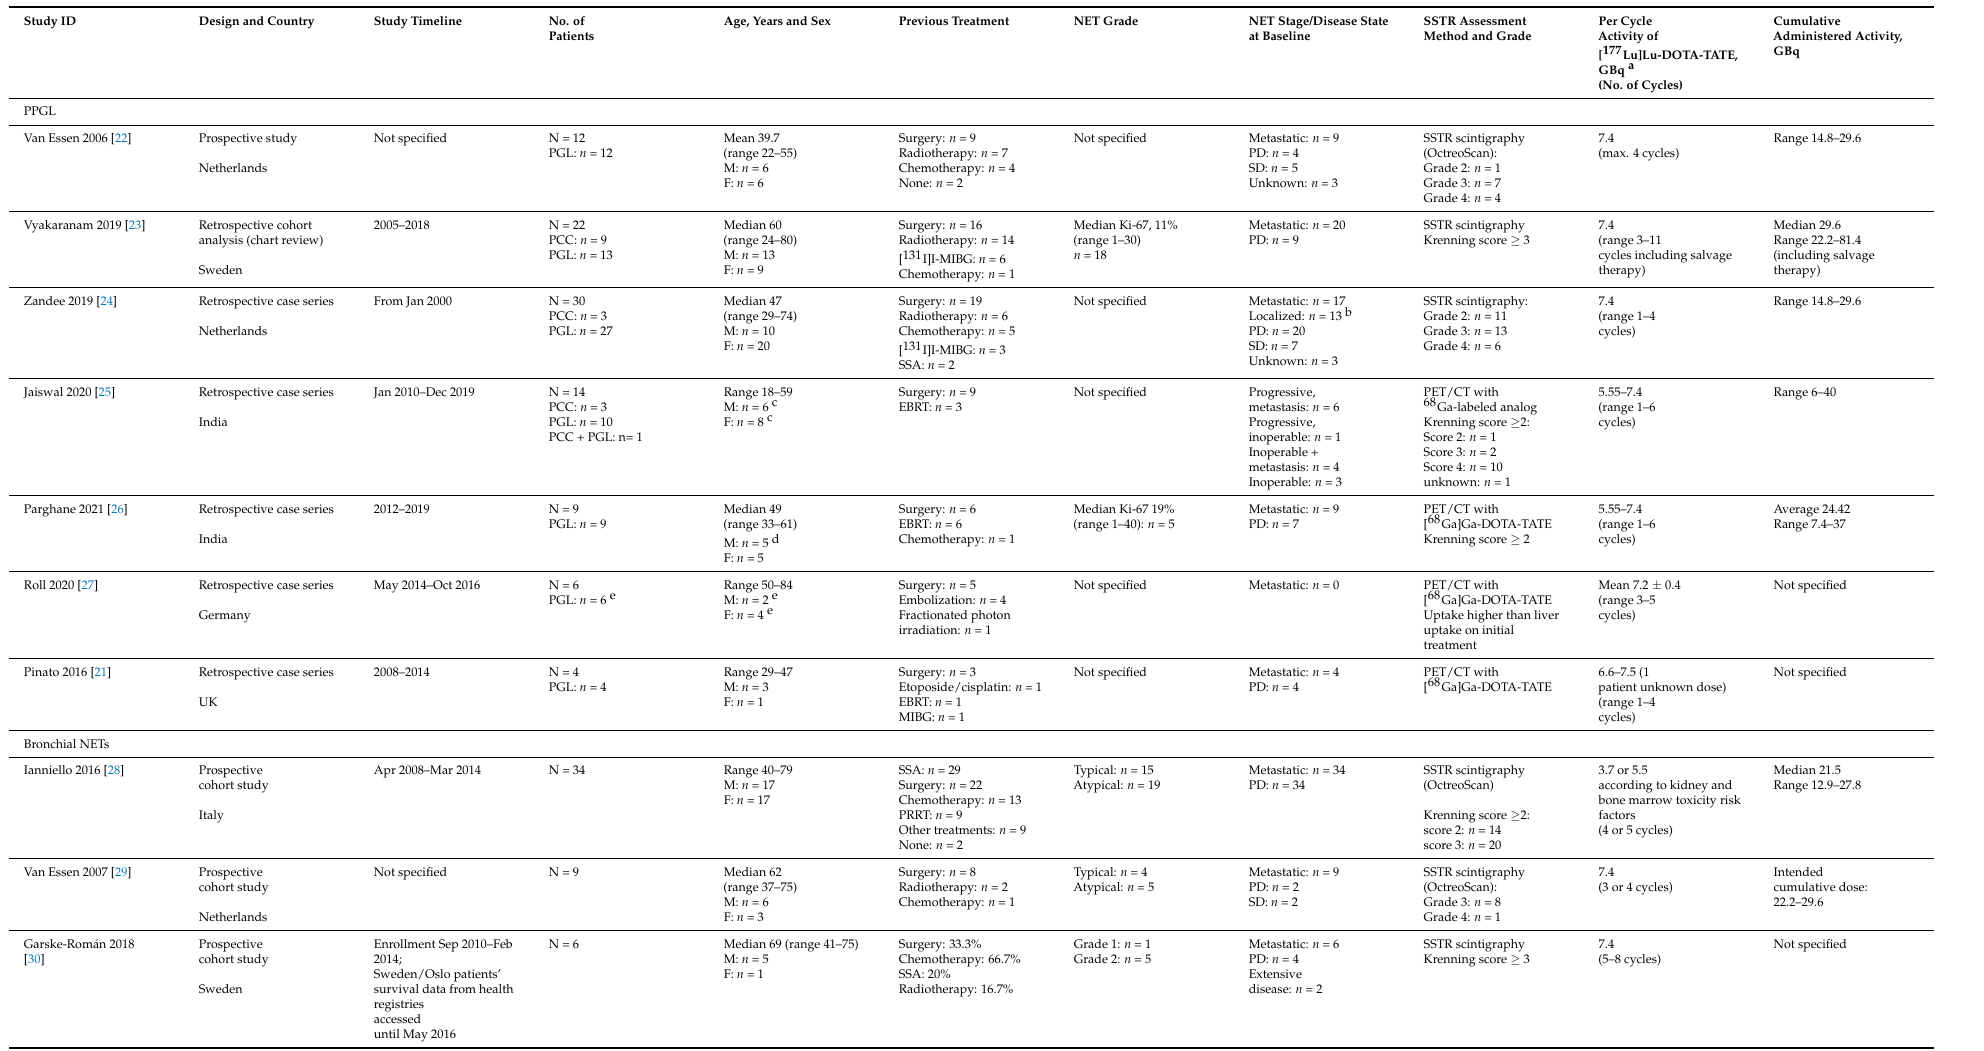
Table 1. Study, patient, and treatment characteristics of included